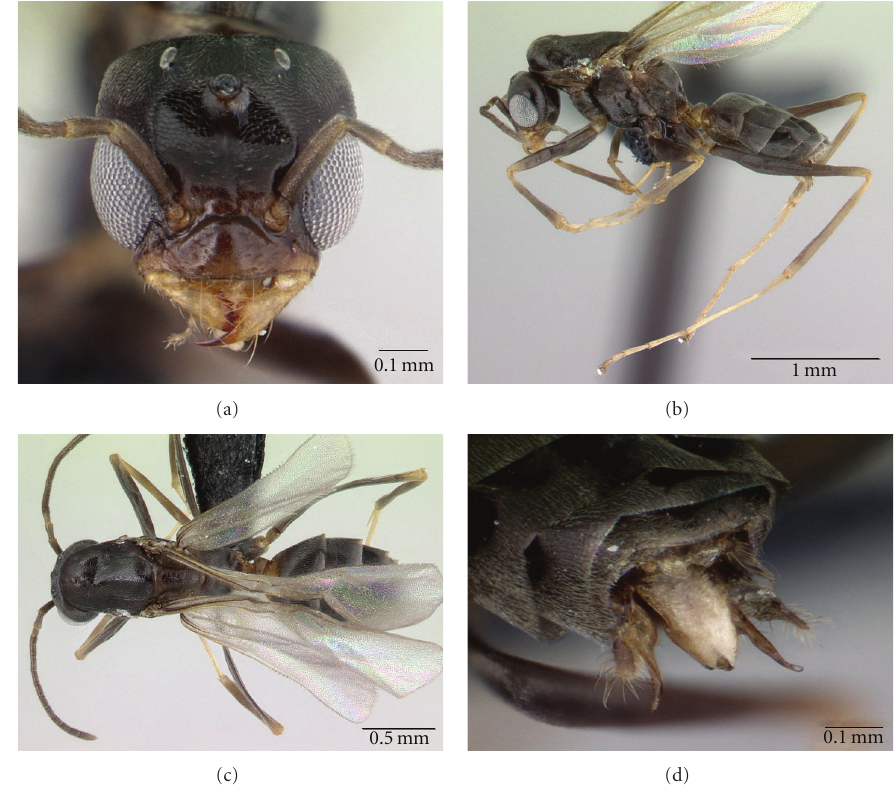
Figure 5: Dorymyrmex biconis male. (a) Head in frontal view; (b) profile of mesosoma; (c) dorsal view; (d) male genitalia in dorsal view (CASENT0192695). Pictures and labels of localities of each photographed specimen are available at http://www.antweb.org/.